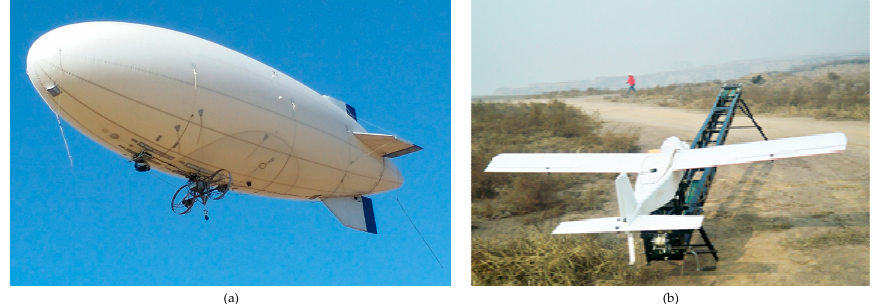
Figure 7. Image of the UAV systems for the datasets. ( a ) The Airship UAV system for Baoding and Yuyao; ( b ) The fixed-wing UAV system for Zhang Jiakou block1 and block2.